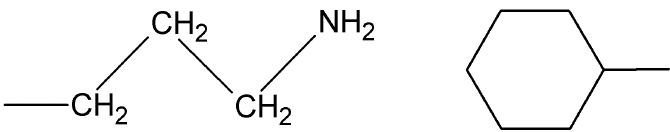
Figure 10. Chemical structure of the 3-aminopropyl (left) and cyclohexyl (right) groups.